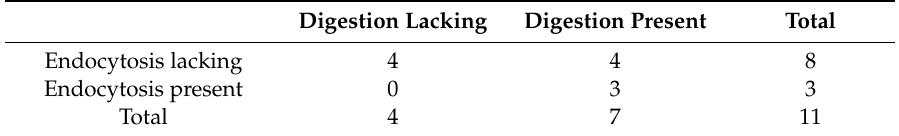
Table 2. Number of species/subspecies showing or lacking digestion or endocytosis respectively. Digestion